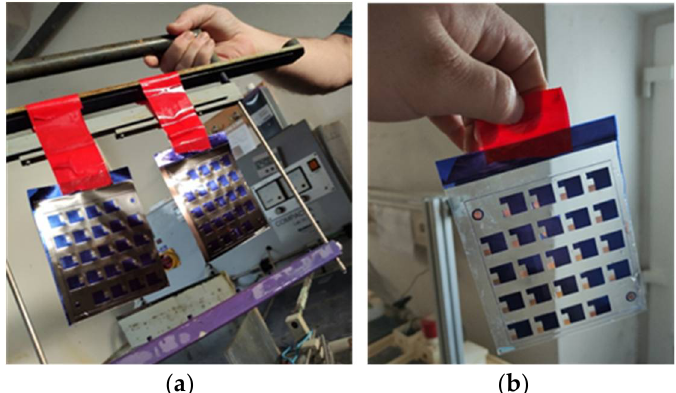
Figure 4. ( a ) Development of PVDF sensors; ( b ) etching of PVDF sensors . Finally, copper wires for both top and bottom electrodes were riveted. Before the